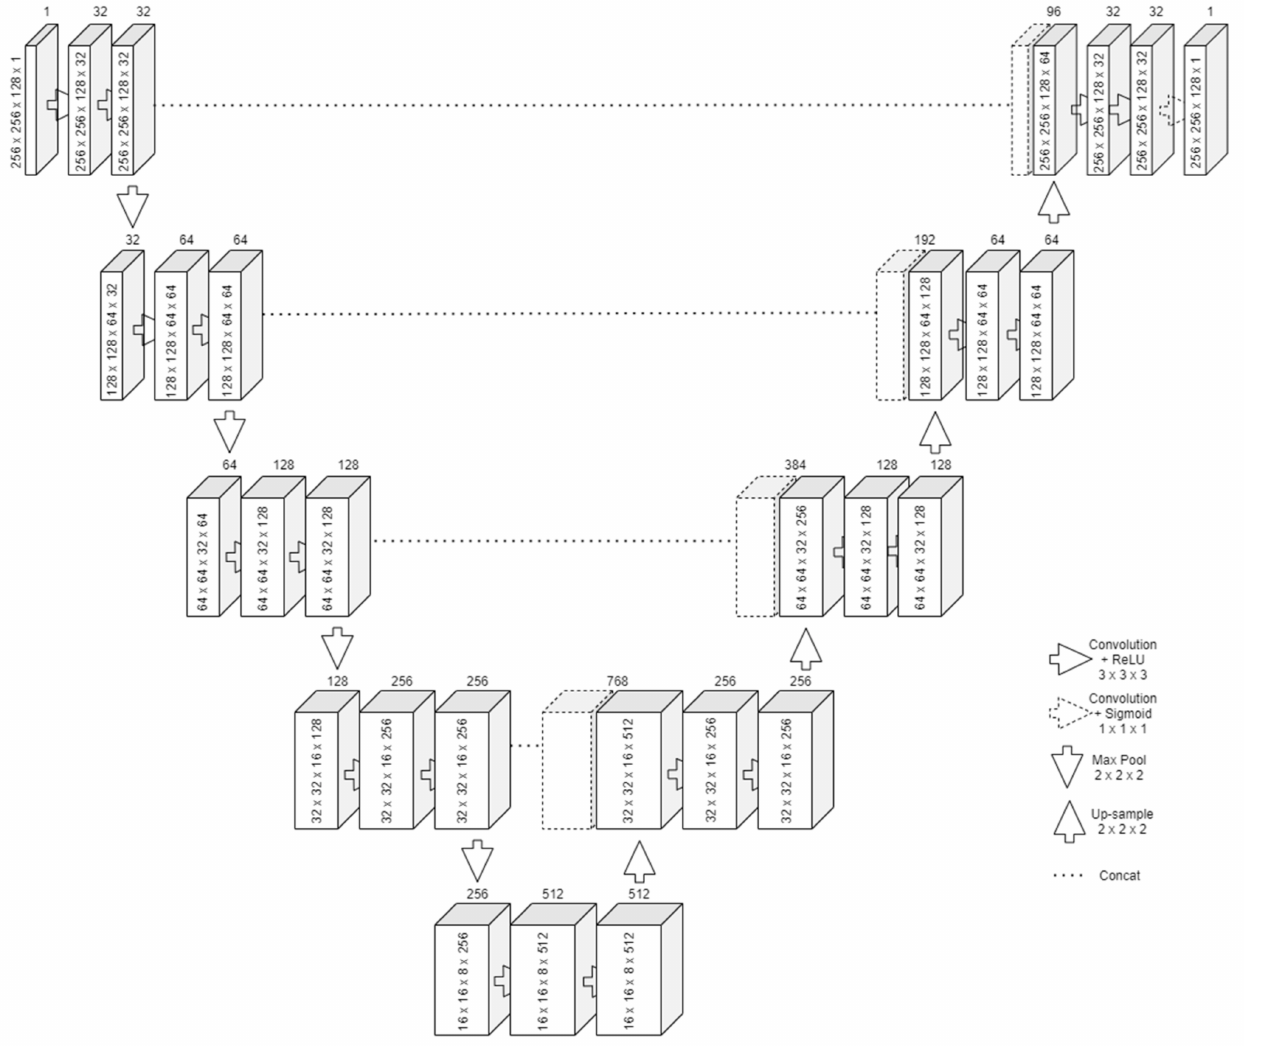
Figure 1. The proposed 3D U-Net